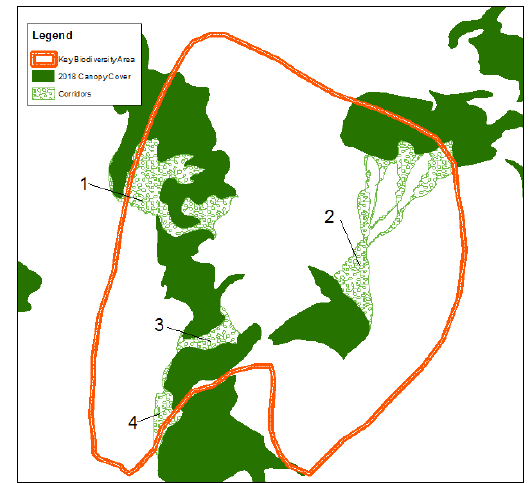
Figure 9. Computed ecological corridors